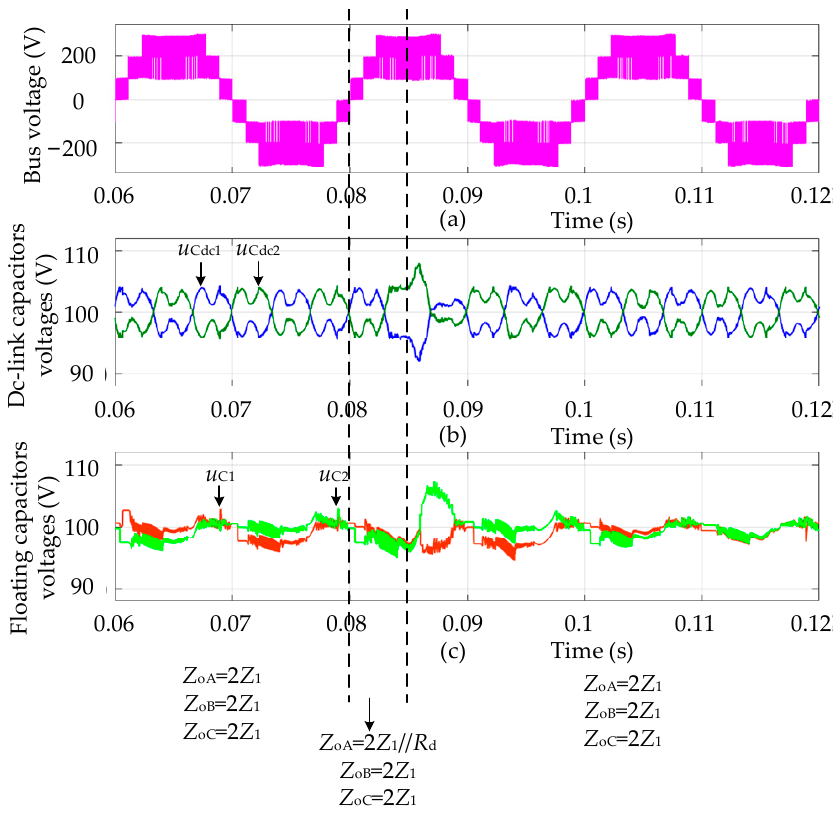
Figure 13. ( a ) The bus voltage, ( b ) DC-link capacitor voltages and ( c ) floating capacitor voltages of the A-phase when the disturbance load was added to the A-phase. When the disturbance load was added to the A-phase, the output voltage of each phase was as shown in Figure 14a, and the FFT result of the A-phase output voltage was as shown in Figure 14b. THD = 3.28%, and the start time was 0.08 s. The change in the output voltage of each phase during the transient process was small. When the disturbance load was added to the A-phase, the output current of each phase was as shown in Figure 15. The amplitude of the A-phase output current i oA increased because of the disturbance load when 0.8 s < t < 0.85 s. After that ( t > 0.85 s), the A-phase output current i oA quickly returned to the steady state. As for i oB and i oC , the disturbance load had no effect because it was only added to the A-phase. All these observed waveforms in the three-phase four-wire system are in good agree- ment with the theoretical analyses, confirming the feasibility of the proposed three-phase SCMLI in the three-phase four-wire system. The recorded efficiency of different topologies is shown in Figure 16. The efficiency decreased with increasing output power. Compared with [27,30], the proposed